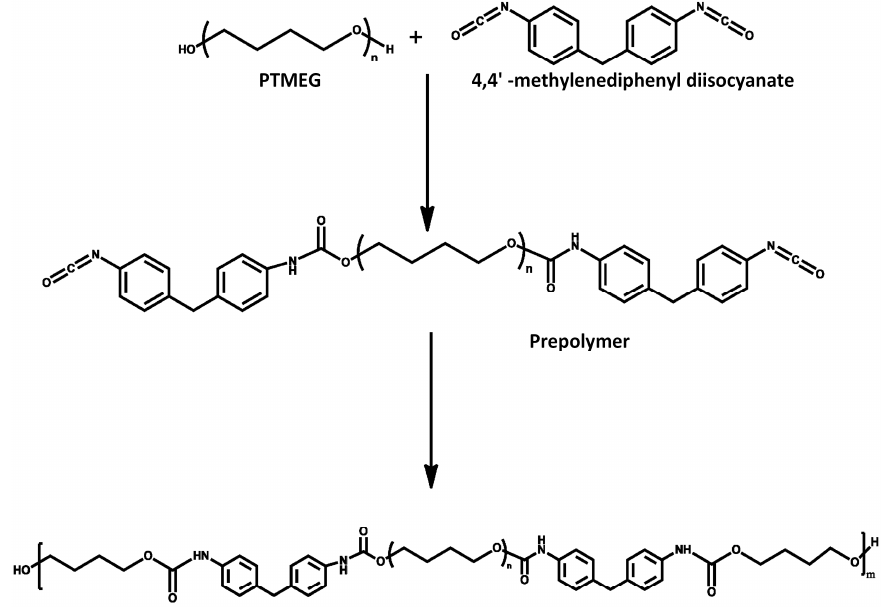
Figure 1. Schematic for synthesis of polyurethane.